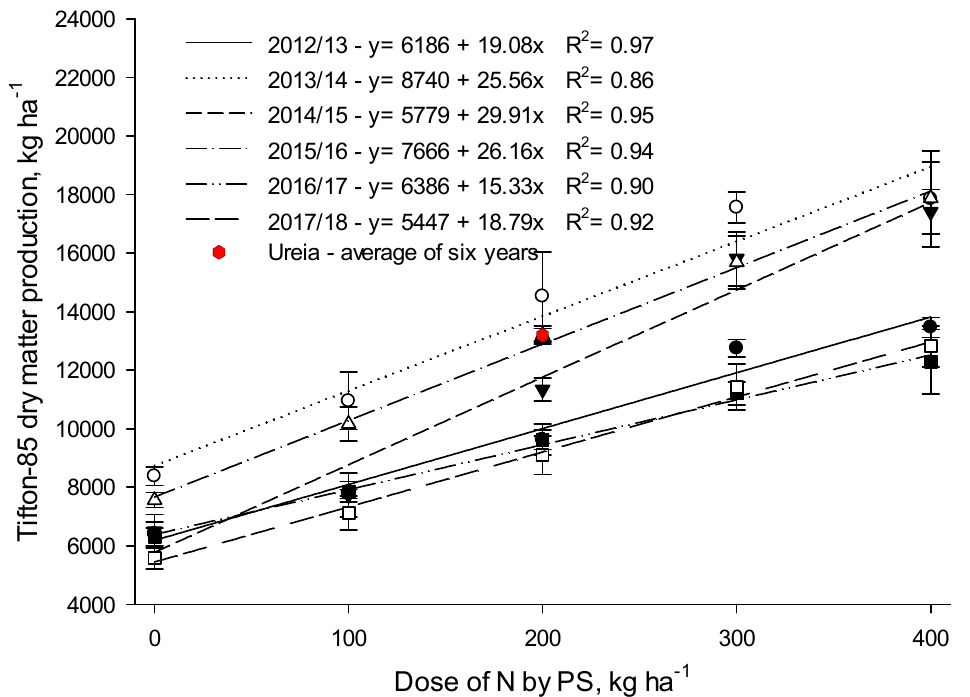
Figure 1. Total dry matter production of Tifton ‐ 85 ( Cynodon sp.) grown under applications of in ‐ creasing doses of pig slurry applications (PS) and urea in the 2012/2013 to 2017/2018 agricultural year. Ibirubá, RS, Brazil, 100 = 100 kg ha − 1 of N using pig slurry (PS); 200 = 200 kg ha − 1 of N using PS; 300 = 300 kg ha − 1 of N using PS; 400 = 400 kg ha − 1 of N using PS; urea = 200 kg ha − 1 of N using urea; 0 = control, no fertilizer application.